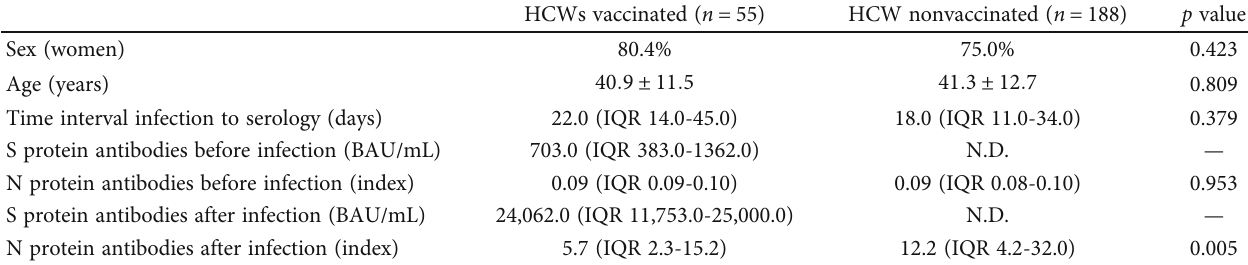
Table 1: Demographic and analytical characteristics of HCWs included in the